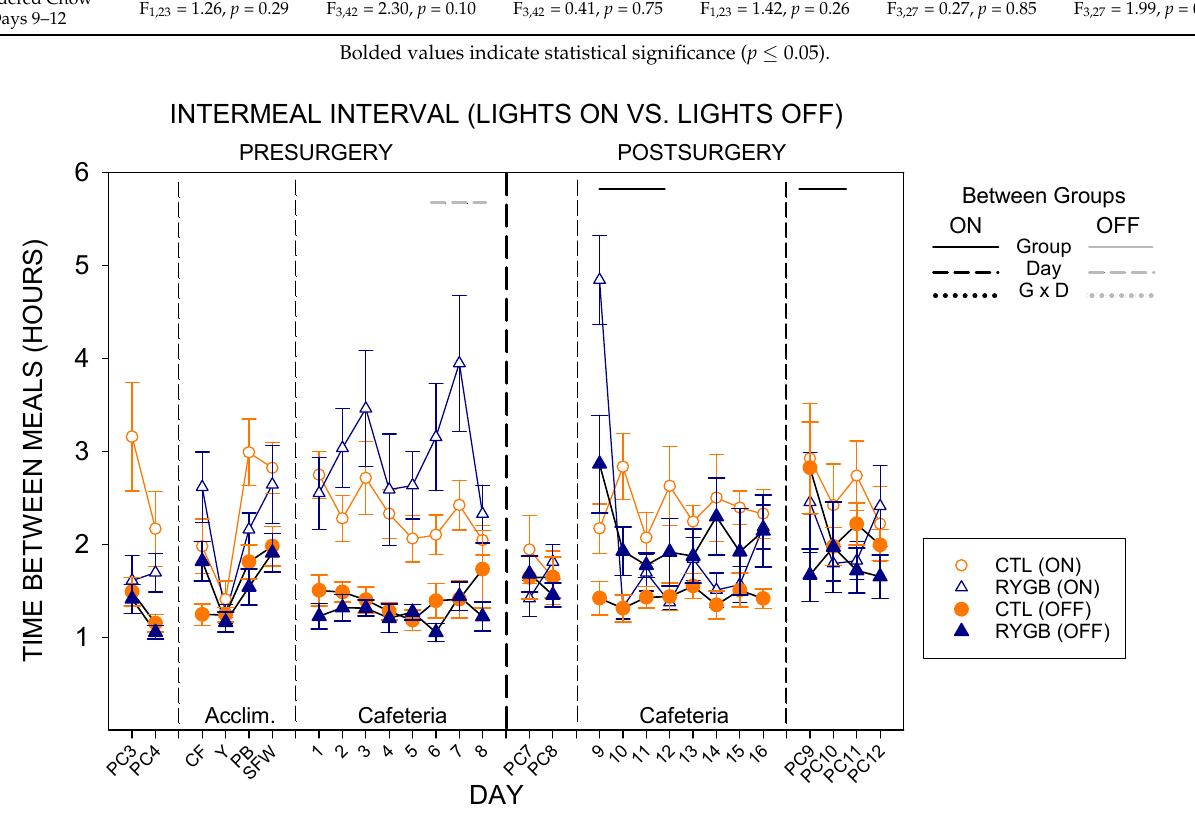
Figure 16. Intermeal Interval for Meals with Lights On vs. Lights Off. Mean (± SE) intermeal interval in hours when lights were on (open symbols) or off (filled symbols) for each day for CTL (combined SHAM and IRON groups, n = 14; orange circles) and RYGB ( n = 11; blue triangles) rats for powdered chow days (PC), acclimation days for each food (Acclim.; CF: chickpea flour; Y: yogurt; PB: peanut butter; SFW: sugar/fat whip), and cafeteria diet days. Dashed vertical lines indicate transitions between diet conditions (thin dashed) and between pre- and post-surgical phases (thick dashed). Statistically significant results from between-group two-way mixed ANOVAs (Table 20) are indicated by the legend; within-group ANOVA results are presented in Table 21. Table 20. Two-way ANOVAs Comparing Intermeal Interval for Lights-On and Lights-Off Meals between Groups for Each Diet Condition.